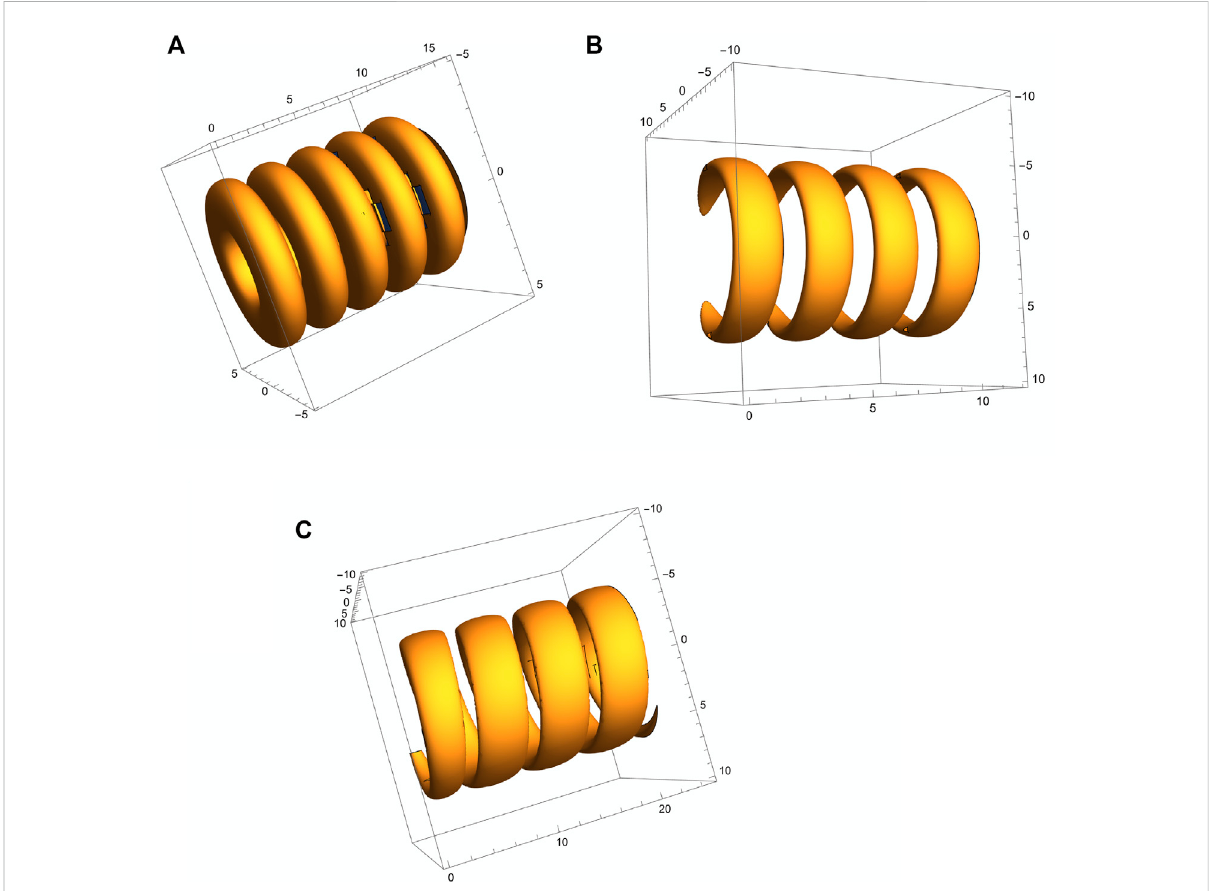
FIGURE 1 Wake fi eld con fi gurations: (A) – Donut wake, excited by a single LG laser mode with azimuthal index l = 1; (B) – self-torque wake, produced by a near-superposition of two LG laser modes l 1 and ł 2 with the same frequency ω 0 ≫ ω p (self-torque con fi guration); (C) – Light-spring, produced by an exact superposition of two LG modes l 1 = 7 and l 2 = 8, with different frequencies, ω 1 ≠ ω 2 . At plasma resonance, ω 2 − ω 1 ≃ ω p this is the generalised beat-wave con fi